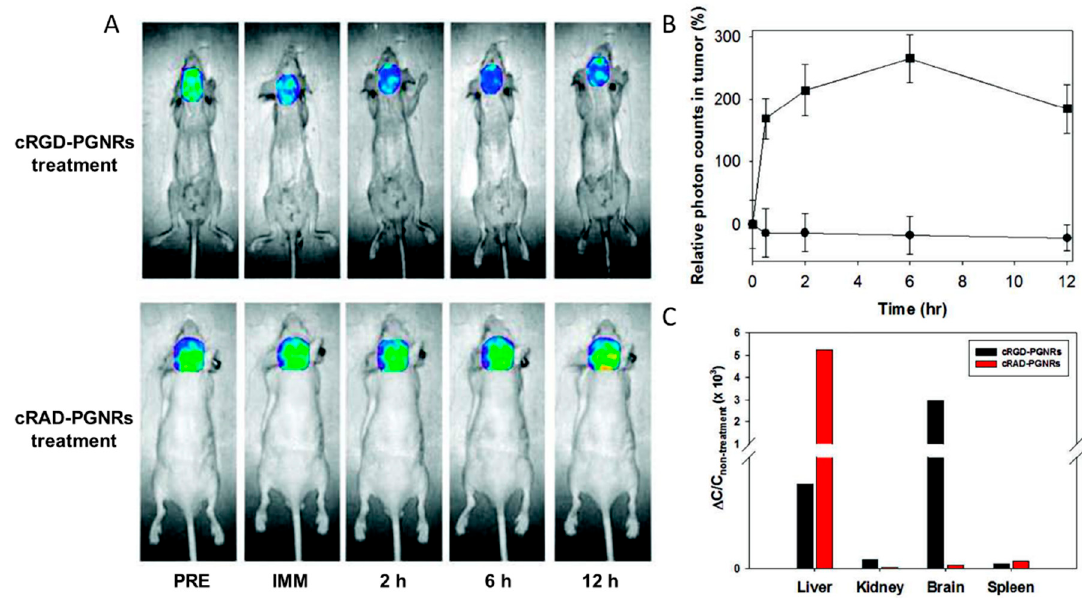
Figure 7. In vivo non-invasive near-infrared (NIR) absorption images of real-time tumor specificity of cRGD-PGNRs. ( A ) In vivo time-dependent brain region biodistribution of cRGD-PGNRs and cRAD-PGNRs as a control; ( B ) relative photon counts of in vivo tumor target specificity of cRGD-PGNRs (square) and cRAD-PGNRs (circle) was recorded; and ( C ) relative quantification of in vivo biodistribution of cRGD-PGNRs and cRAD-PGNRs in different tissues [81].